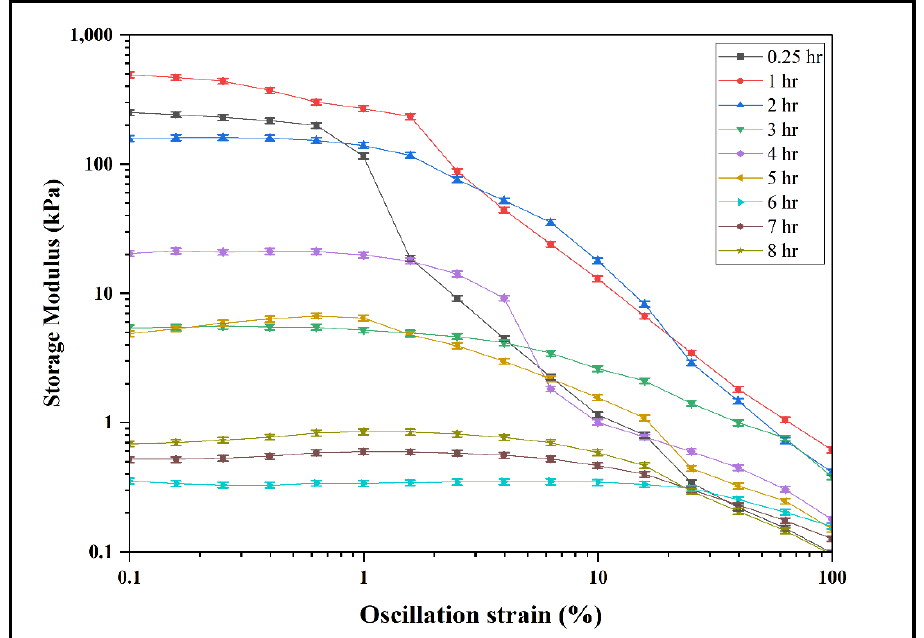
Figure 10. Storage modulus vs. oscillation strain graphs obtained from the amplitude sweep at 25 °C.